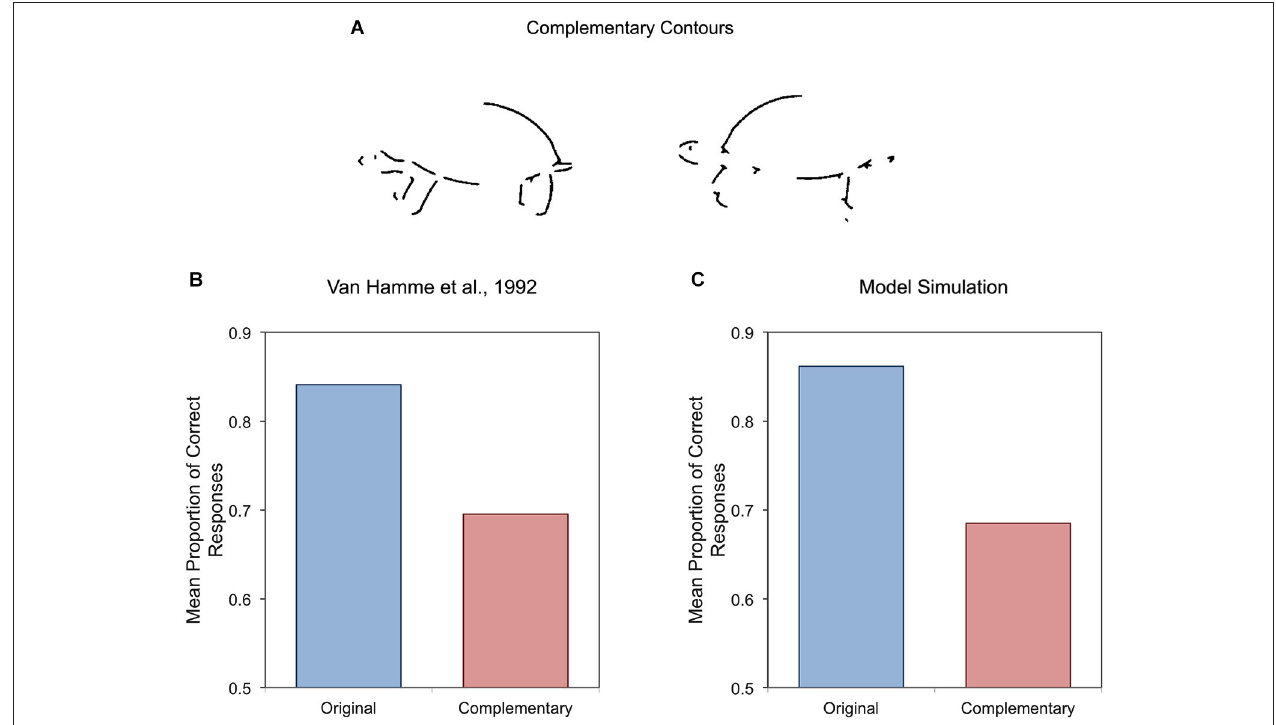
FIGURE 10 | Examples of the stimuli used by Van Hamme et al. (1992) to study transfer of recognition performance from partial contours to their complementary contours (A), together with the performance of pigeons (B) and a hierarchical model (C) during test